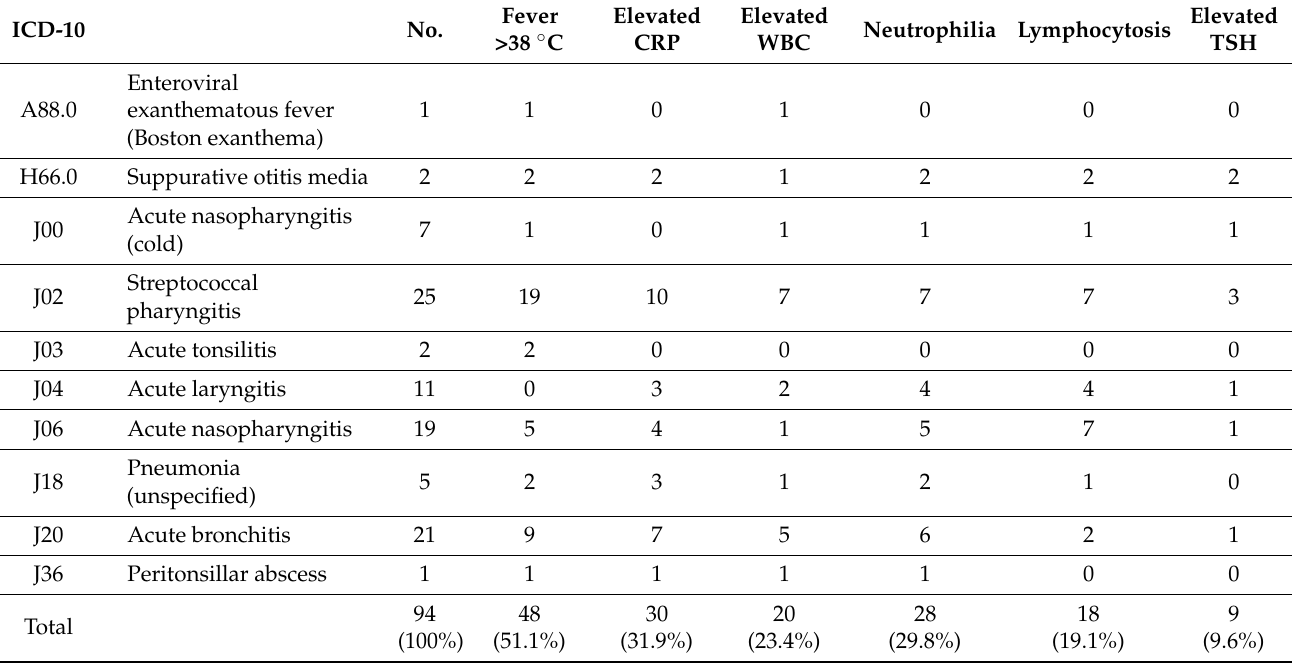
Table 1. The clinical characteristics of the analyzed group of